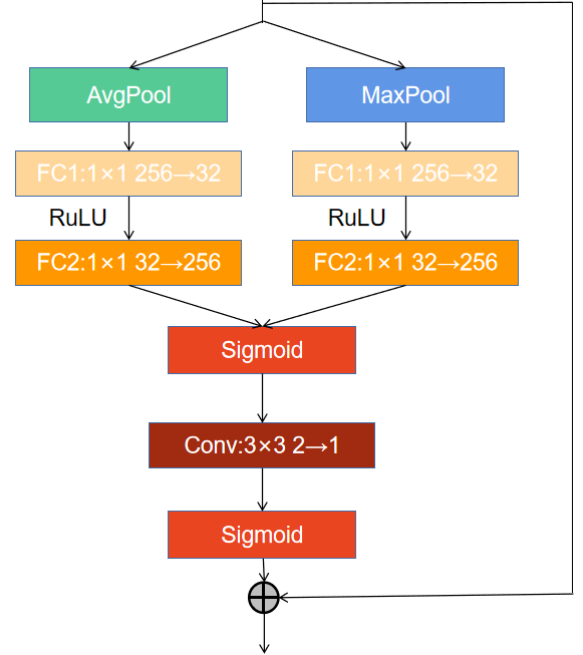
Figure 7. Network flow diagram of feature map transmission process in the Res-Attention module.